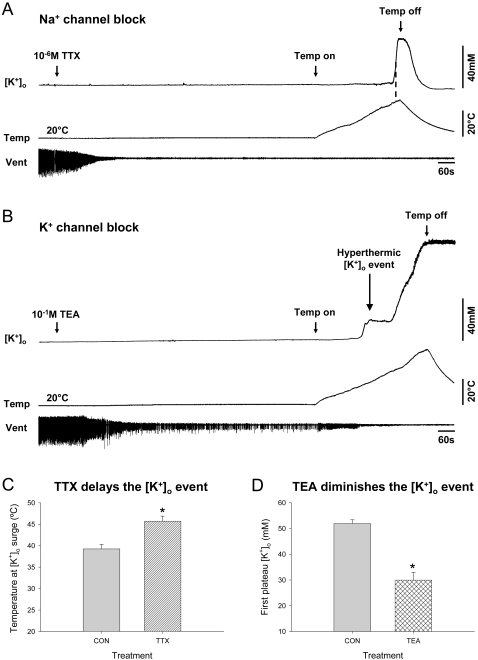
The hyperthermic [K+]o event is delayed by blocking Na+ channels and neural activity using TTX and is diminished by blocking K+ channels using TEA. A. 10−6 M TTX abolished electrical activity within minutes while [K+]o remained stable.The abrupt rise in [K+]o was not significantly diminished by TTX. The hyperthermic [K+]o event occurred at a significantly higher temperature (measured at dotted line) in the absence of electrical activity (46±1°C) compared to CON locusts (39±1°C) (C) (NCON = 17; NTTX = 15). B. 10−1 M TEA significantly reduced the hyperthermic [K+]o event (NCON = 17; NTEA = 6) (D). [K+]o increased with continued temperature increase to ∼60°C.